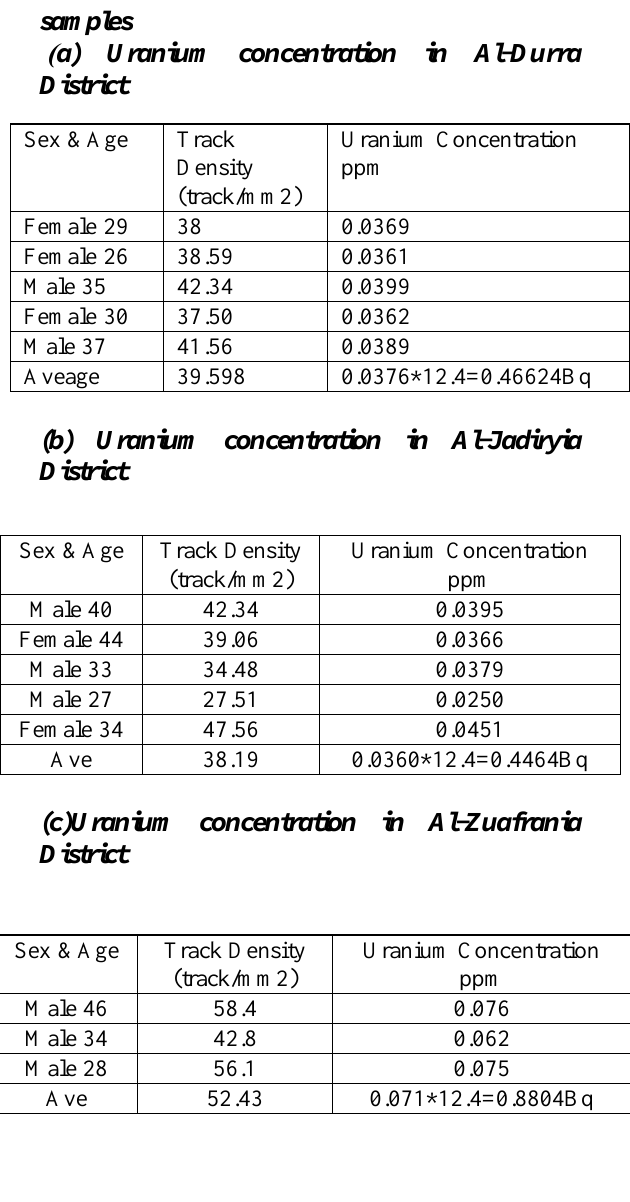
Table 1: Uranium concentration in